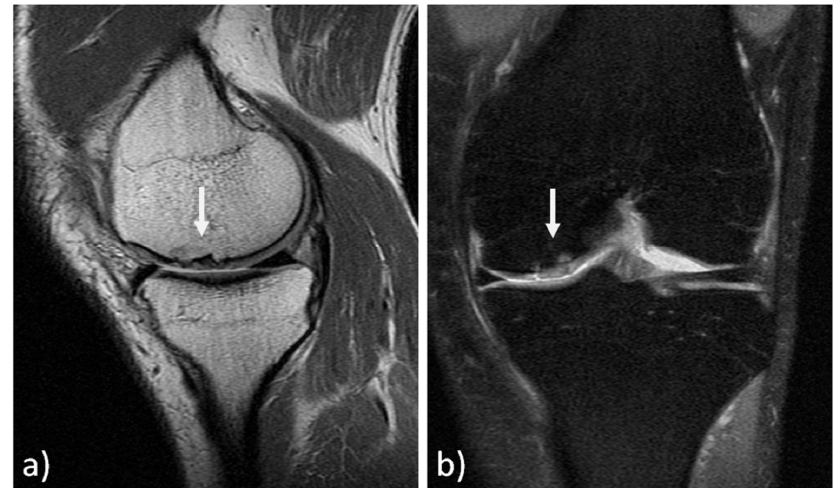
Figure 3. MRI evaluation at 11 years’ follow-up of a medial femoral condyle lesion treated with mosaicplasty in a 37-year-old man. Sagittal 3D "Cube" PD ( a ) and coronal PD FAT SAT ( b )